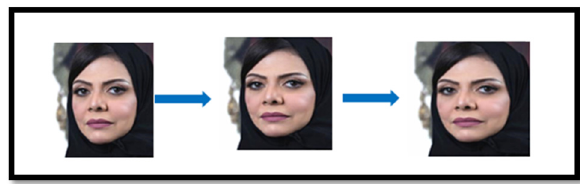
Figure 11: Secret message from original image, normalized image, and stegno image.